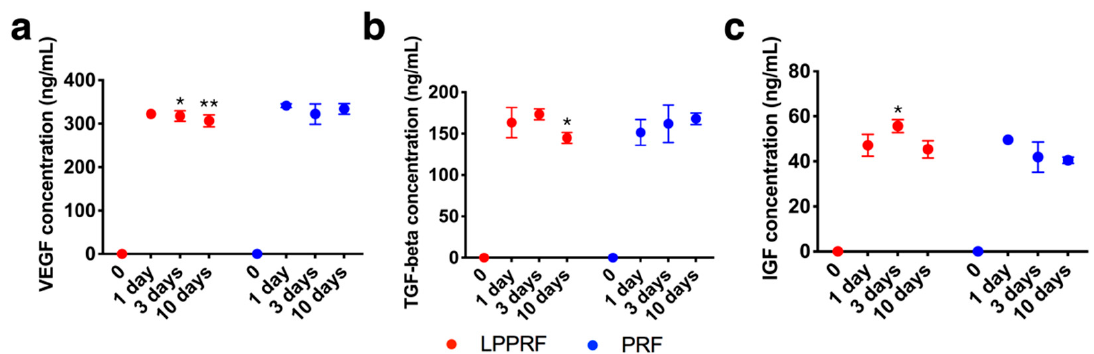
Figure 3. Growth factors released from platelet-rich fibrin before and after repeated freeze drying: ( a ) vascular endothelial growth factor (VEGF), ( b ) insulin-like growth factor-1 (IGF-1) and ( c ) transforming growth factor beta (TGF- β ). (Individual data points are shown as means ± SD; N = 5 per group; * p < 0.05 and ** p < 0.01).